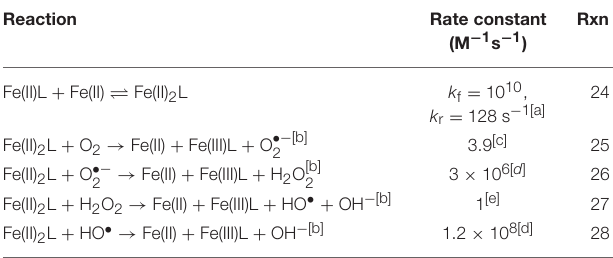
TABLE 3 | Additional reactions used in the Fe(II) 2 L model.